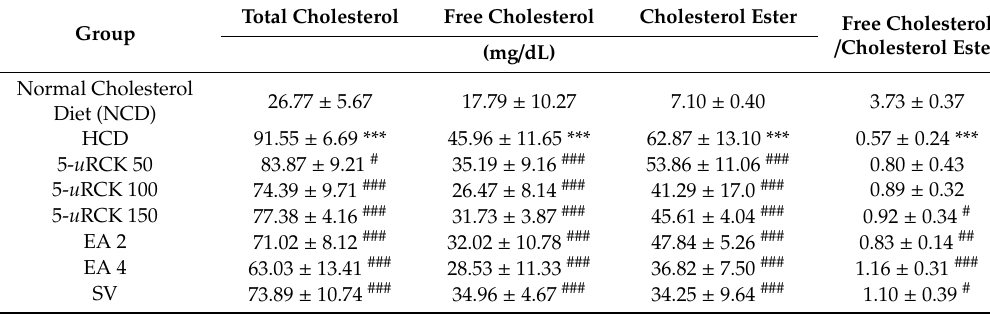
Table 5. Levels of total cholesterol, free cholesterol, and cholesterol ester in the livers of 5- u RCK-treated or ellagic acid-treated HCD-fed rats. The total cholesterol, free cholesterol, and cholesterol ester levels and free cholesterol to cholesterol ester ratio levels were detected after 5- u RCK, ellagic acid, or simvastatin treatment for five weeks. 5- u RCK and ellagic acid supplementation decreased hepatic lipid levels in rats fed an HCD. *** p < 0.001 versus control (NCD) group. # p < 0.05, ## p < 0.01, ### p < 0.001 versus HCD group. All data are shown as the mean ± SD ( n =